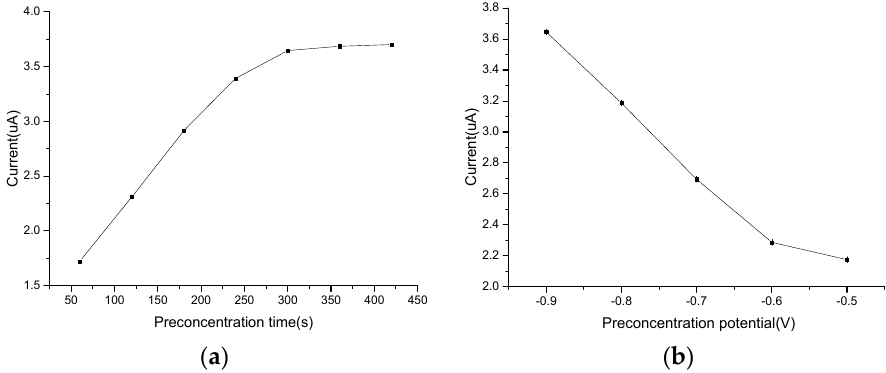
Figure 5. DPSV carried out on the PPy/MWCNT/Au in the presence of 100 μ g·L − 1 Pb 2+ in 0.1 M HCl of ( a ) different accumulation time (deposition potential: − 0.9 V); and ( b ) different deposition potential (accumulation time: 300 s).